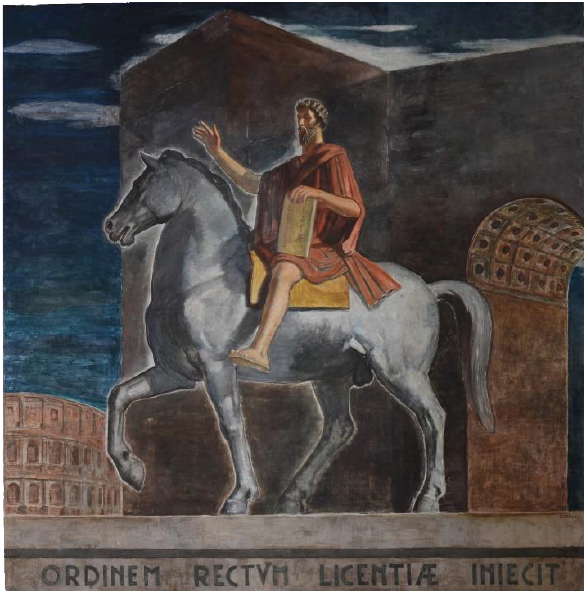
Fig 3. Ottavio Steffenini, Marco Aurelio a cavallo , as it appears today after restoration.